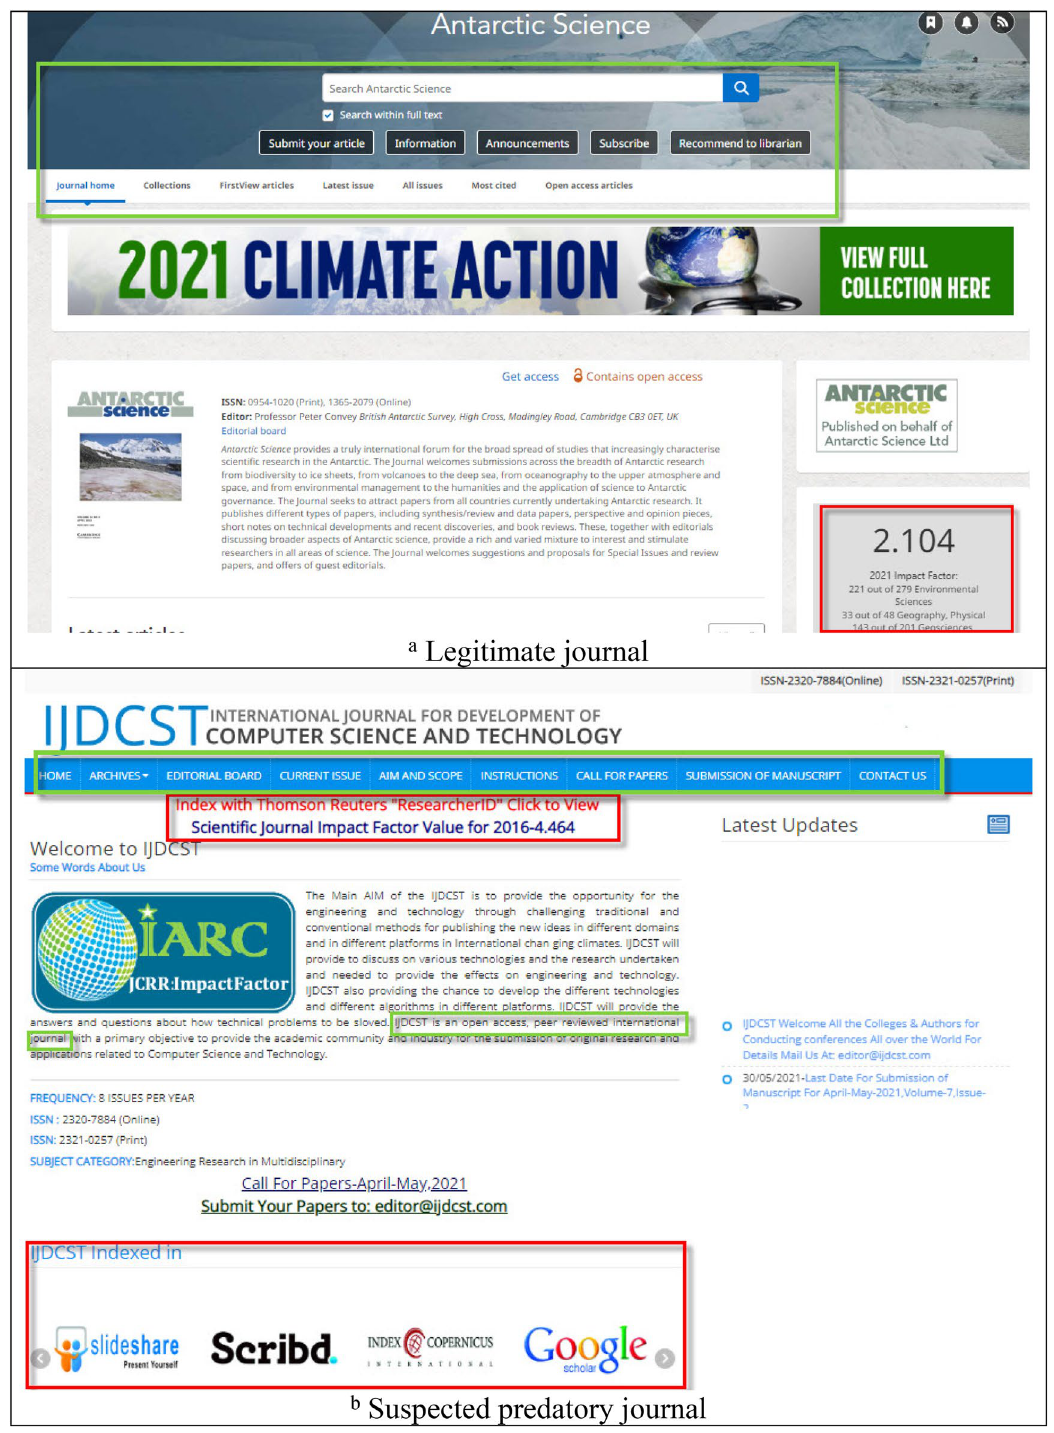
Figure 1. Our proposed academic journal predatory checking (AJPC) system identified the first journal, Antarctic Science , as legitimate, and the second, International Journal for Development of Computer Science and Technology , as potentially predatory. Similarities between the two websites are noted in the color box frames 1a was captured from https:// www. cambr idge. org/ core/ journ als/ antar ctic- scien ce# and 1b was captured from http:// ijdcst.